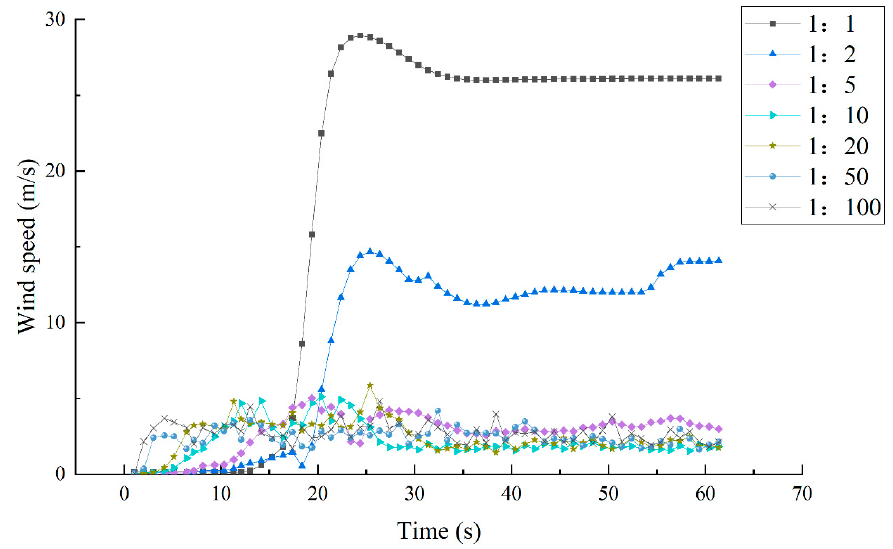
Figure 7. Change process of atomization wind speed with time under different similarity scales.